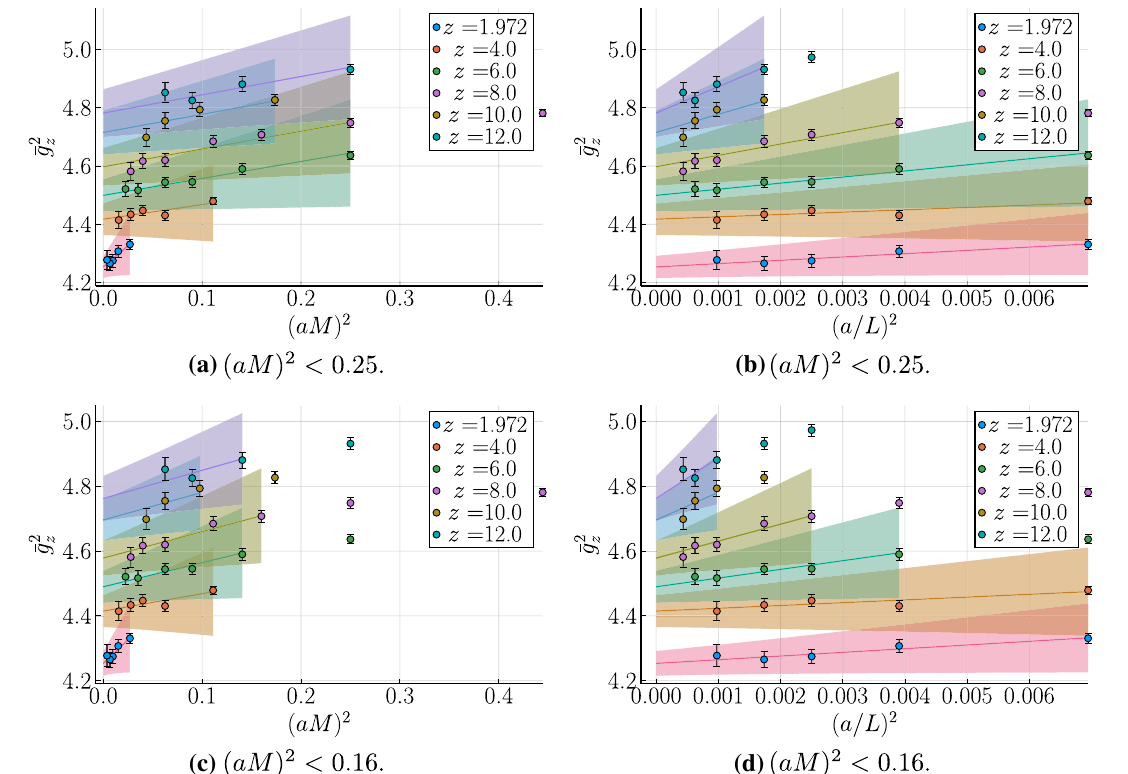
( z ) in the the assumed 100% uncertainty of b g is not included in the error bars of 0 . 3 the points. However, it is propagated into the uncertainties of the global fit shown by the shaded